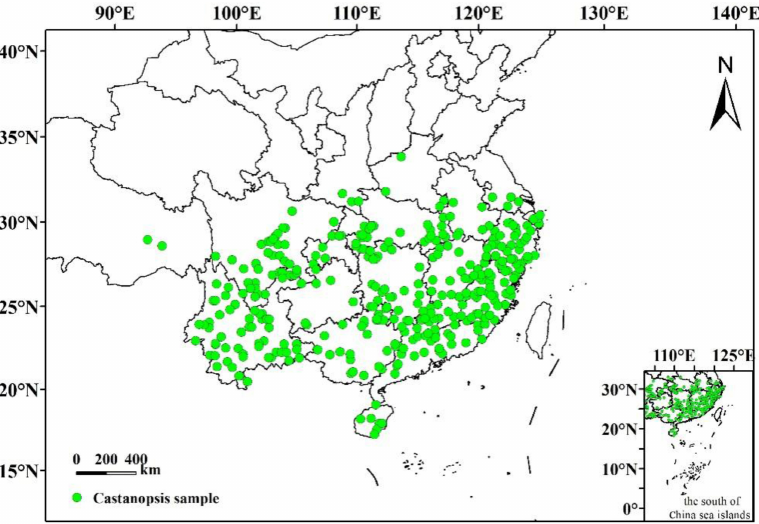
Figure 6. Sample distribution of C. hystrix Miq. in China.